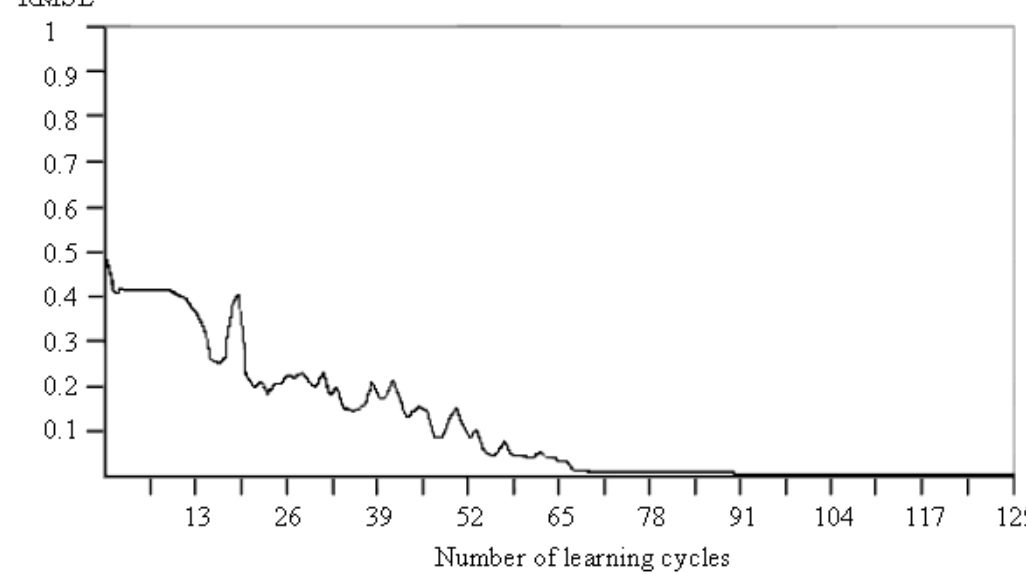
Figure 3. The root-mean-squared error (RMSE) of training vs. the number of learning cycles for the 18PC_IR-MS-ANN